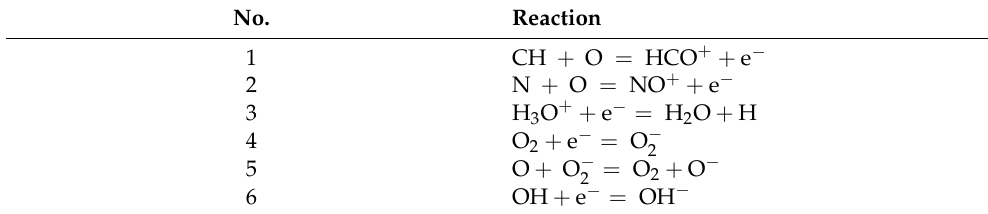
Table 1. The list of reactions with charged particles [31].